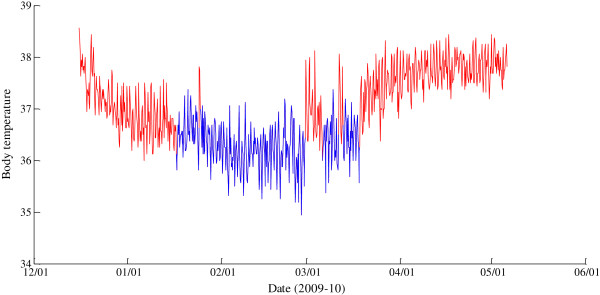
Passive periods of wintering determined by change-point analysis from body temperature data. The body temperature (°C) of an adult male raccoon dog (M9) was measured every 120 min with intra-abdominal data loggers in winter 2009–2010, red line = active periods, blue line = passive wintering.